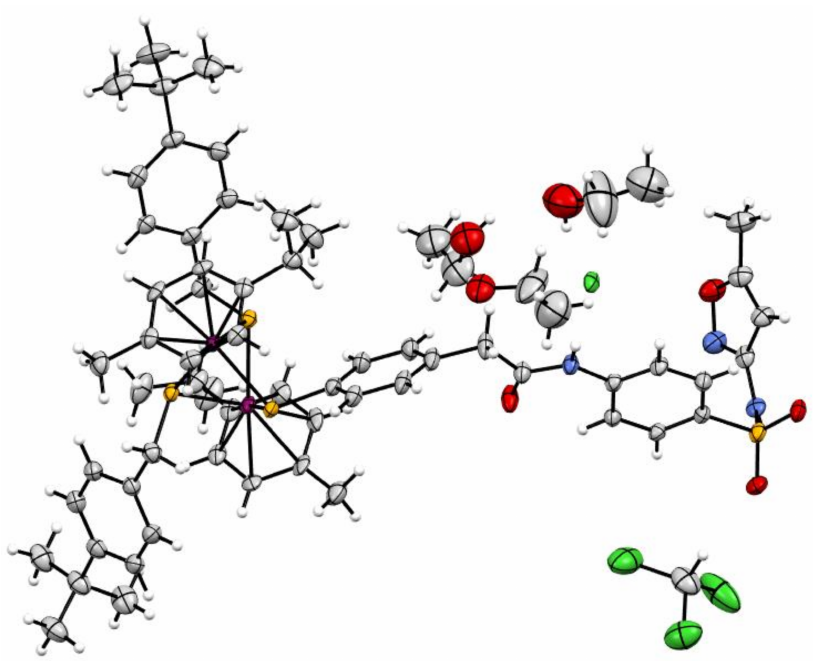
Figure 3. ORTEP representation of complex 9 (thermal ellipsoids are 50% equiprobability envelopes, and H atoms are spheres of arbitrary diameter; the asymmetric unit contains one organometallic complex, three EtOH, and one CHCl 3